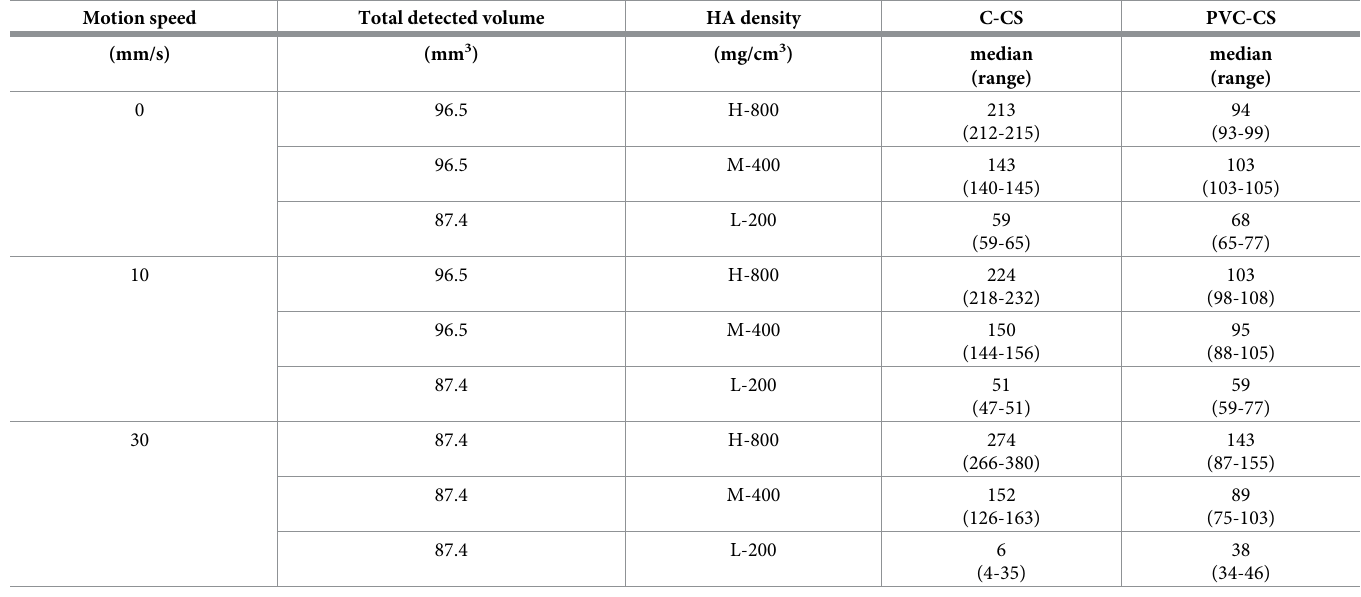
Table 5. Median and range of the CAC volumes over three different acquisitions of the SATI phantom for different settings, i.e. without simulated motion and with simulated velocities of 10 and 30 mm/s and with calcium insert HA densities (H-800, M-400, L-200 mg/cm 3 ). Results are calculated using C-CS and PVC-CS, and grouped per simulated velocity. The median and range values have been rounded for easier